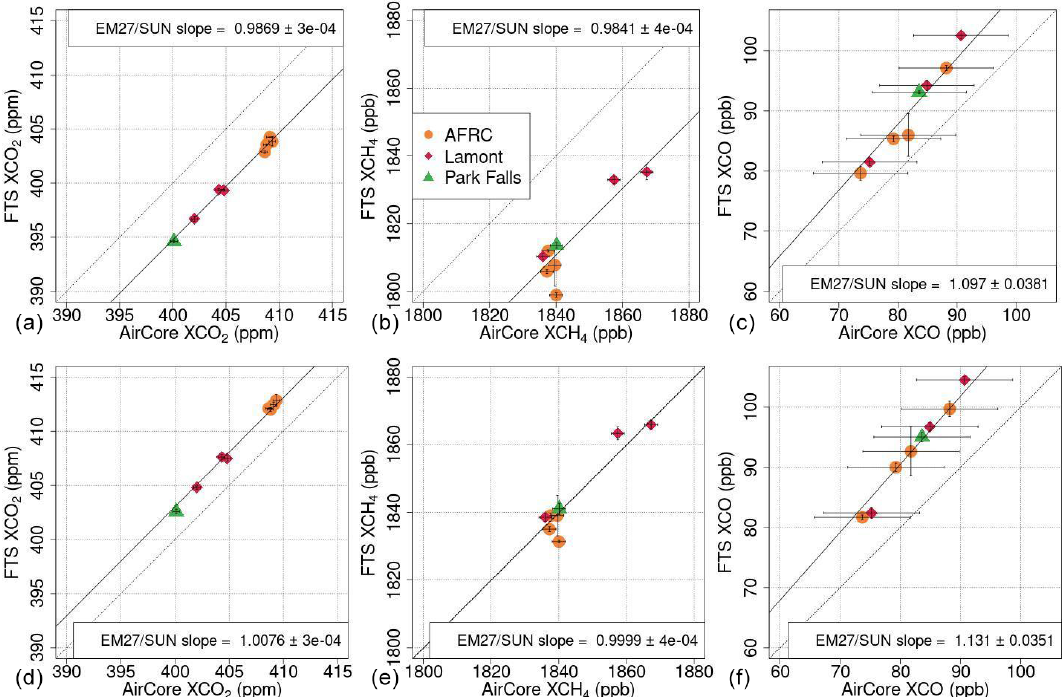
Figure 7. Correlation plots, regression line slopes, and errors in Xgas from the EM27/SUN devices (ta at AFRC remote site and tb at Lamont and Park Falls) and integrated column of AirCores collected at three of the TCCON sites. Panels (a) – (c) use GGG2014 for the retrieval, and panels (d) – (f) use GGG2020.